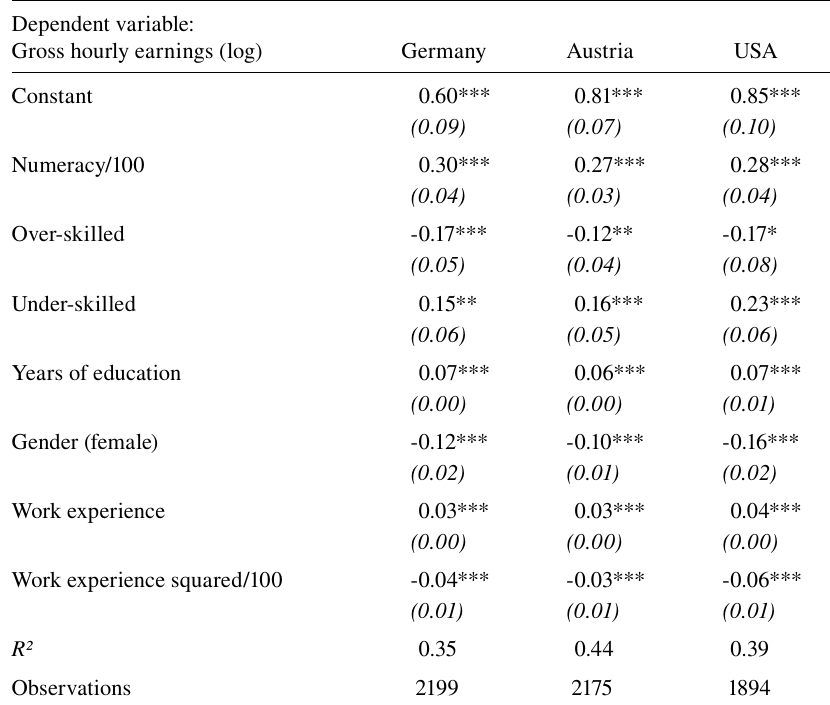
Table A.6 Mincer regressions with skill-mismatch according to our newly developed skill- mismatch